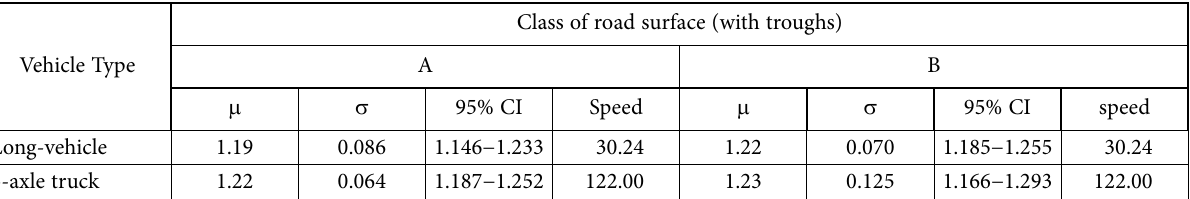
Table 4. Mean value ( µ ) and standard deviation ( σ ) of DAF for road classes A and B combined with troughs (critical speed in km/h)